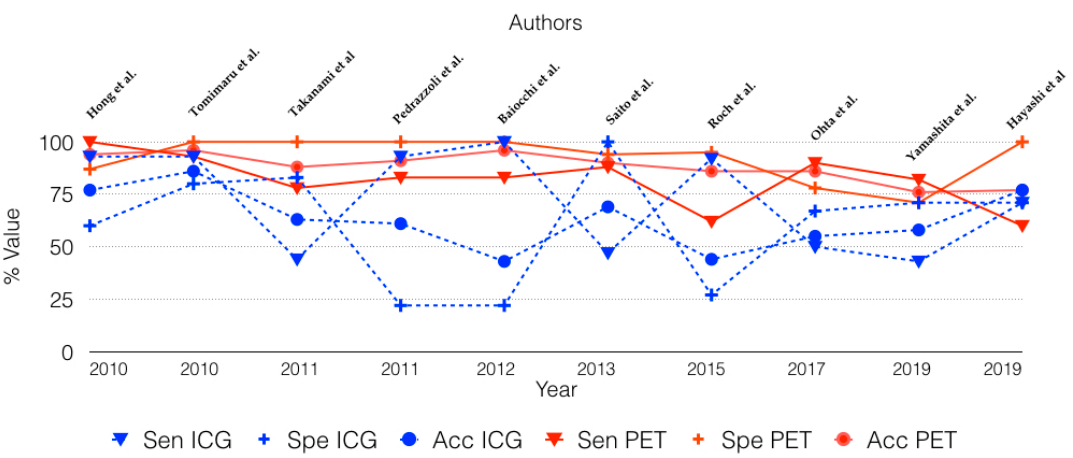
Figure 2. Changes in the sensitivity (SEN), specificity (SPE), and accuracy (Acc) of 18-FDG-PET (PET) and International Consensus Guidelines (ICG) over time.